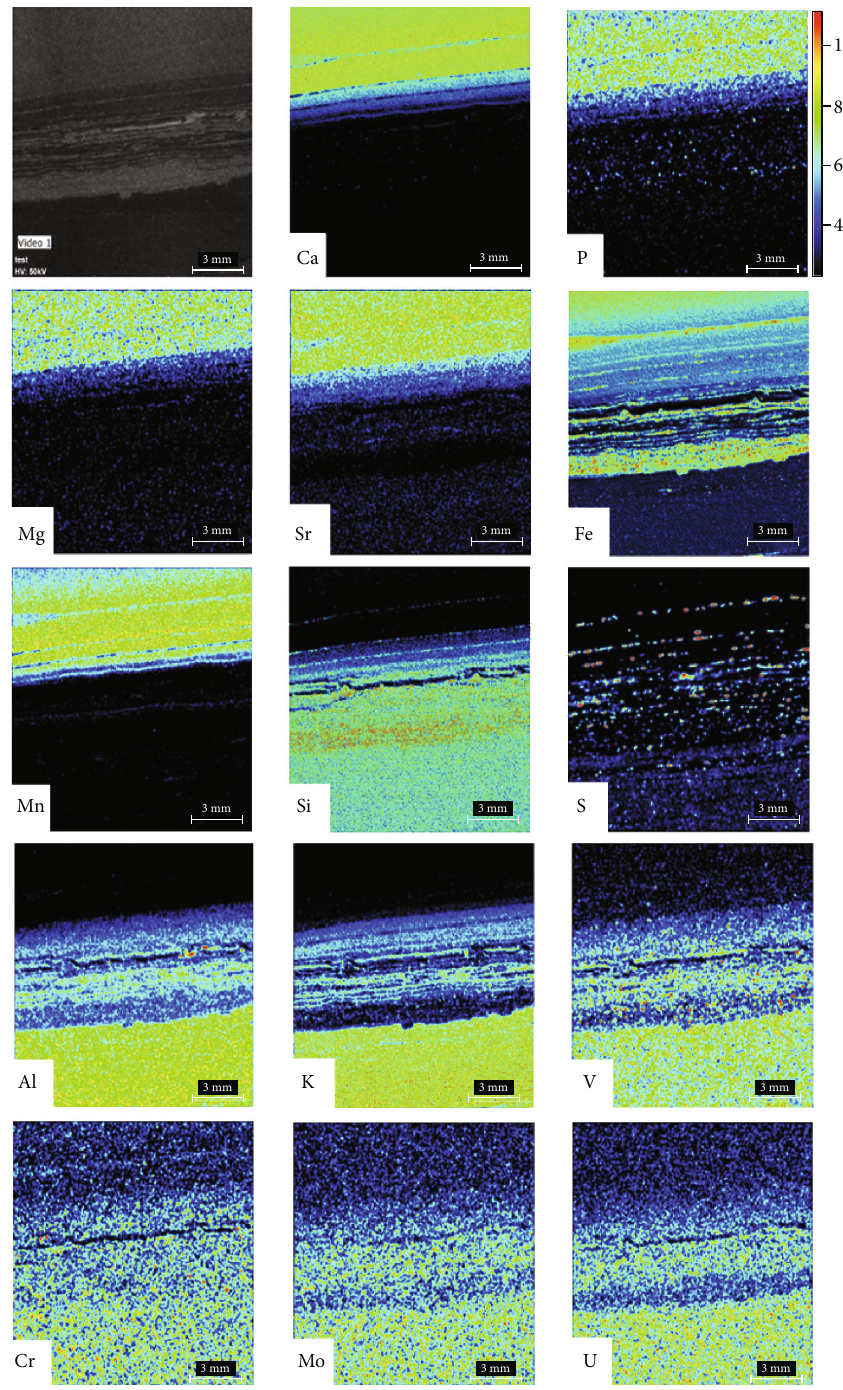
Figure 12: Multielement imaging of area C in Figure 1(d) by using XRF. Image size 14 × 12 : 9 mm ( 1400 × 1290 pixels); 10 μ m pixel size; 4ms exposure time per pixel. All images share the same color